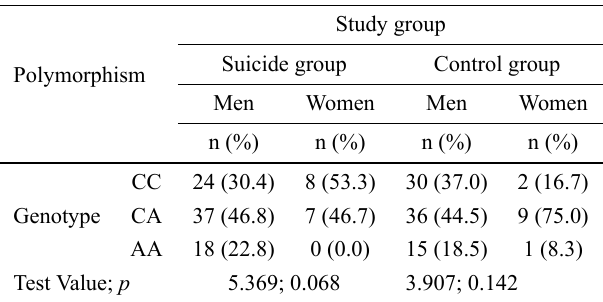
Table 5. Comparison of sex and presence of TPH-1 gene rs1800532 polymorphism in study